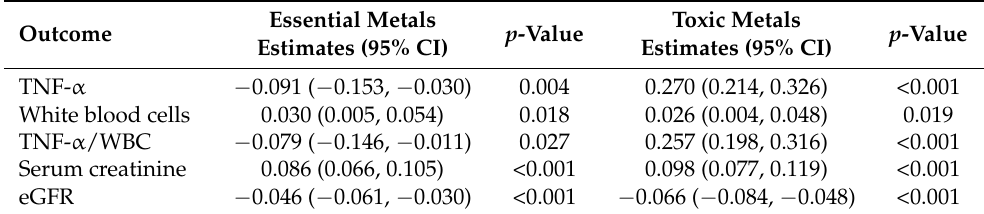
Table 4. Results of adjusted group WQS regression